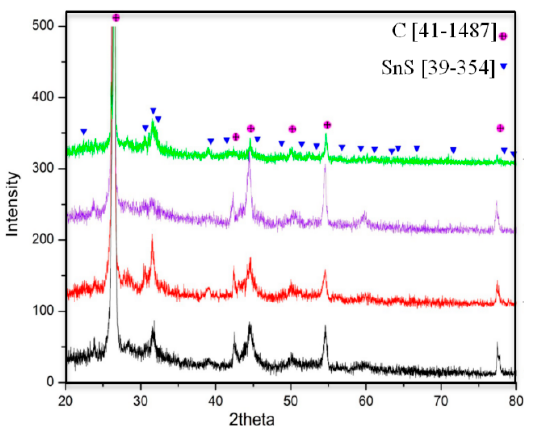
Figure 3. X-ray diffraction (XRD) of the SnS/carbon composites before cycling. Green : 20SnS/AG, purple : 20SnS/AG, red : 20SnS/MCMB, black : 10SnS/MCMB. purple : 20SnS/AG, red : 20SnS/MCMB, black :